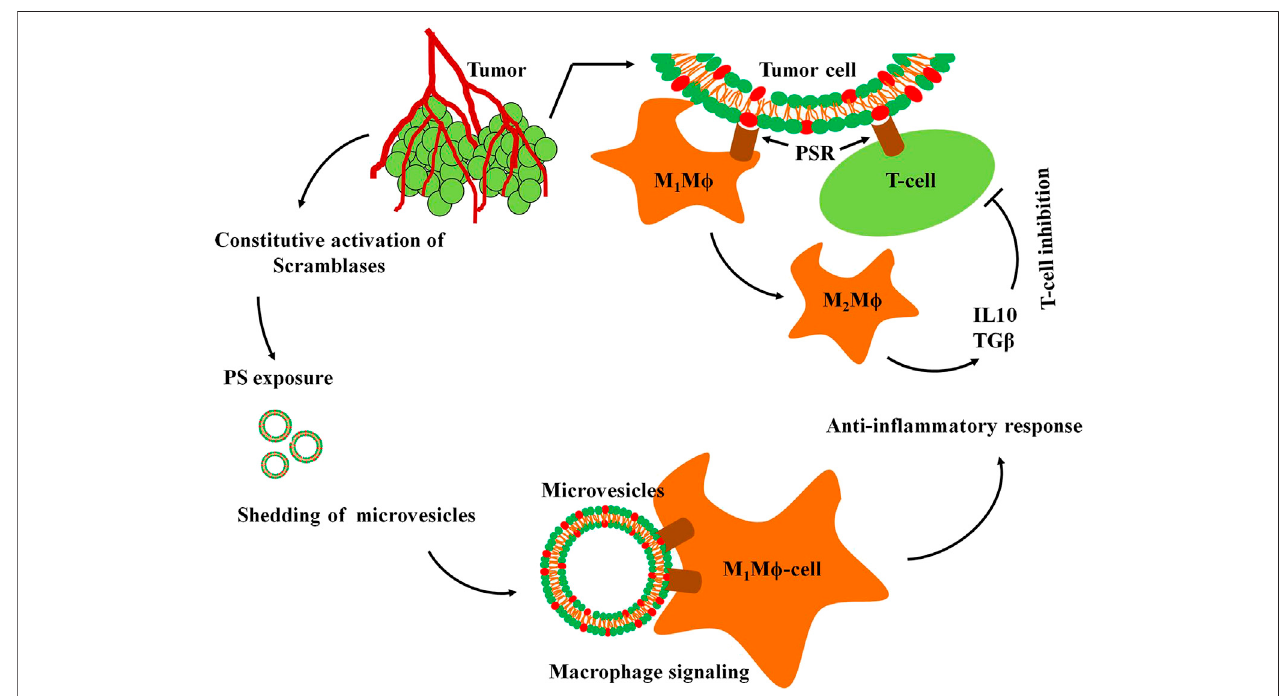
FIGURE 3 | Immunosignaling in the TME. Altered signaling mechanisms in tumor cells activates scramblases resulting in constitutively high PS exposure on their surfaces.PSexposurestimulatessheddingofmicrovesicles(MVs)fromtumor cellswithsurfaceexposedPSintothetumor microenvironment.ThePSontumorcellsor MVs are recognized by the PS receptors (PSR) of M1M ϕ macrophages and T-cells that initiate the anti-in fl ammatory response. The in fl ammatory M1M ϕ macrophages are converted into the non-in fl ammatory M2M ϕ macrophages that in turn, secrete interleukin 10 (IL10) and tumor growth factor β (TGF β ) triggering inhibitory response against T